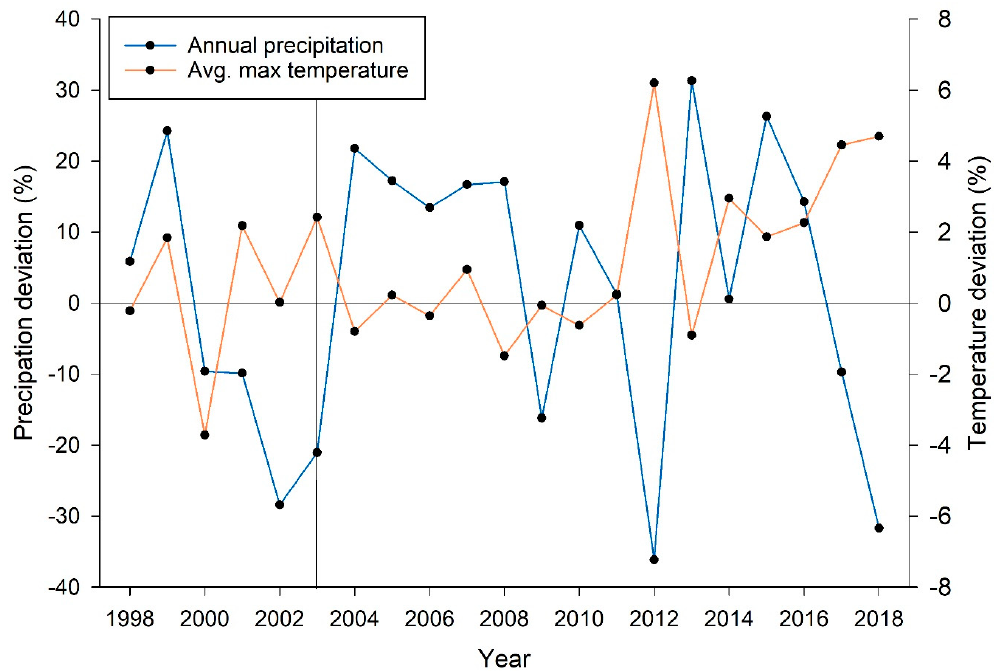
Figure 1. Precipitation (left axis) and temperature (right axis) percent deviation (deviation from long-term mean 1950 to 2018) spanning from 1998 to 2018 from Vallecito dam (https://wrcc.dri.edu/cgi-bin/cliMAIN.pl?co8582) near Pagosa, Colorado, USA. The vertical line represents pretreatment sampling.